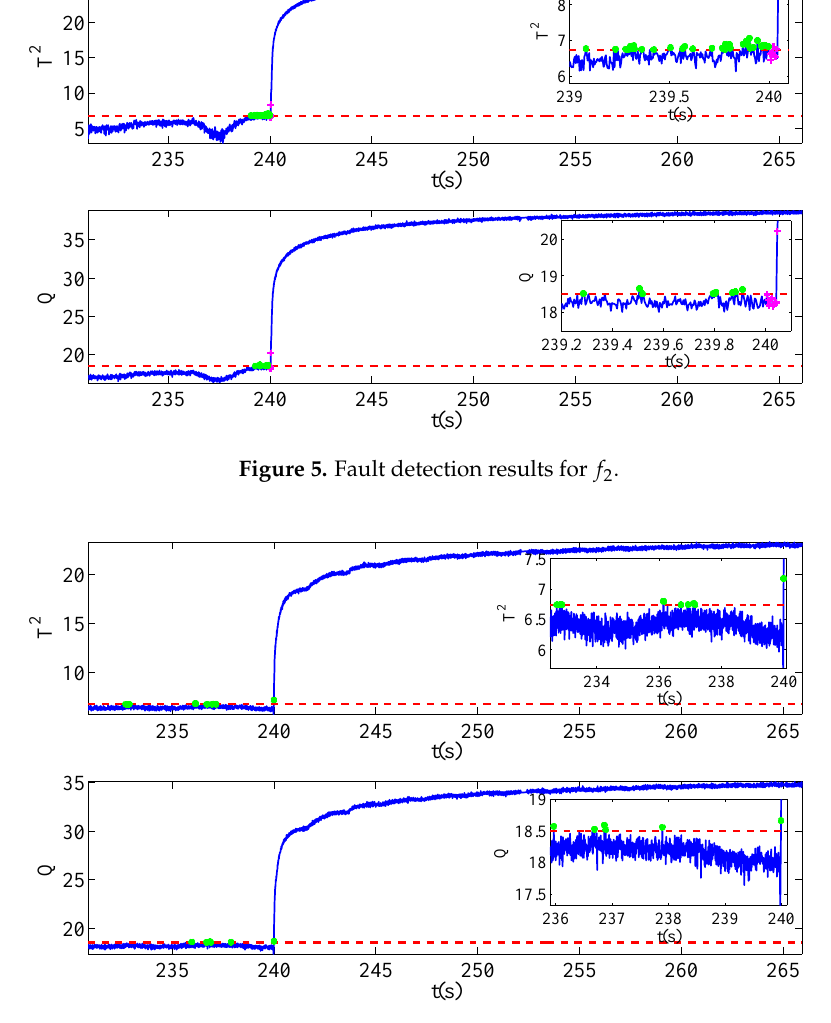
Figure 6. Fault detection results for f 3